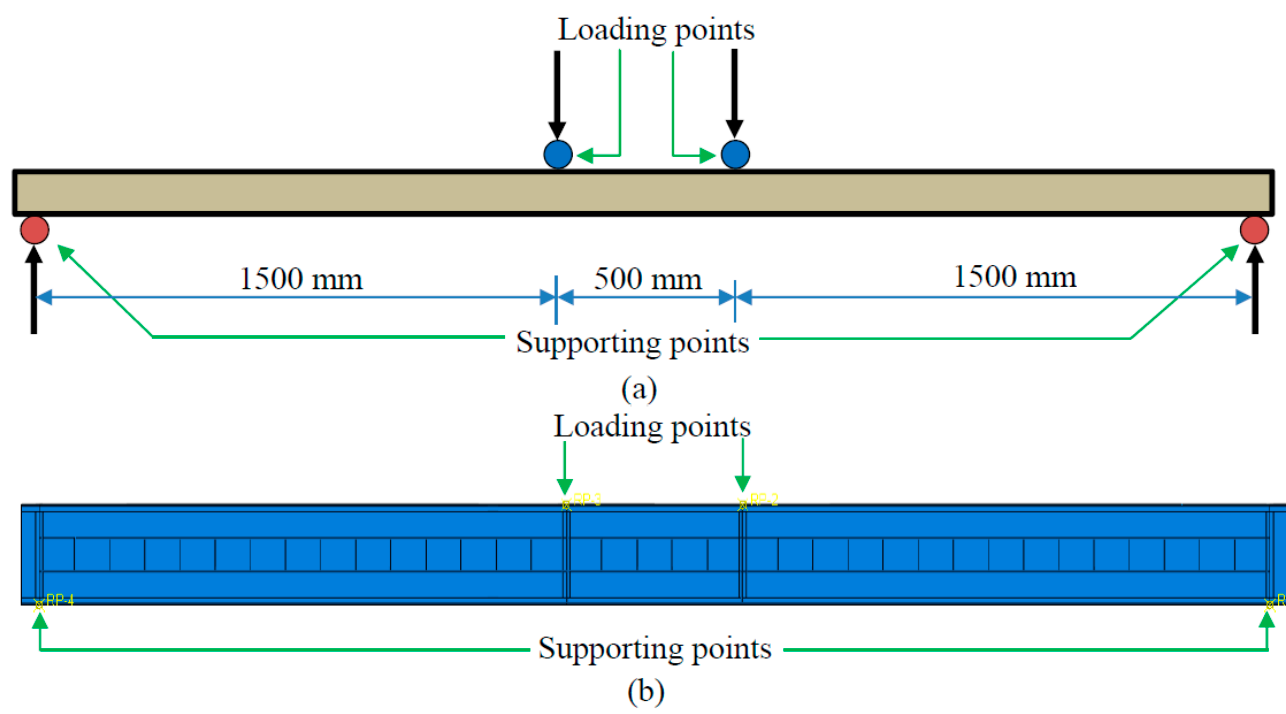
Figure 2. Four-point bending set-up ( a ) Schematic diagram and ( b ) Numerical model. The CFS sections were modelled using the S4R element, which is a four-node quad- rilateral shell element, whilst loading and supporting plates were generated with the R3D4 element. Mesh sensitivity analysis was performed for proper mesh application to